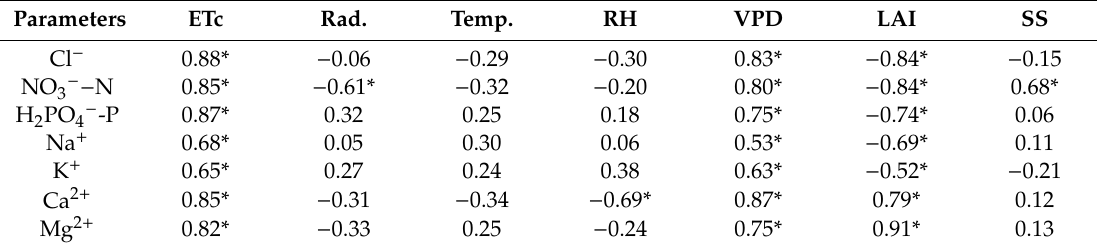
Table 3. Correlation coe ffi cients (r) between petiole sap concentrations (Cl − , NO 3 − -N, H 2 PO 4 − -P, Na + , K + , Ca 2 + , and Mg 2 + ) (mg L − 1 ) and the climatic parameters (ET c (mm day − 1 ), global radiation (MJ m − 2 day − 1 ), temperature ( ◦ C), relative humidity (RH) (%) and vapor pressure deficit (VPD) (kPa), LAI ( − ), and soil solution (SS) nutrient concentrations (Cl − , NO 3 − , H 2 PO 4 − , SO 42 − , K + , Na + , Ca 2 + , and Mg 2 + ) (mmol L − 1 ).